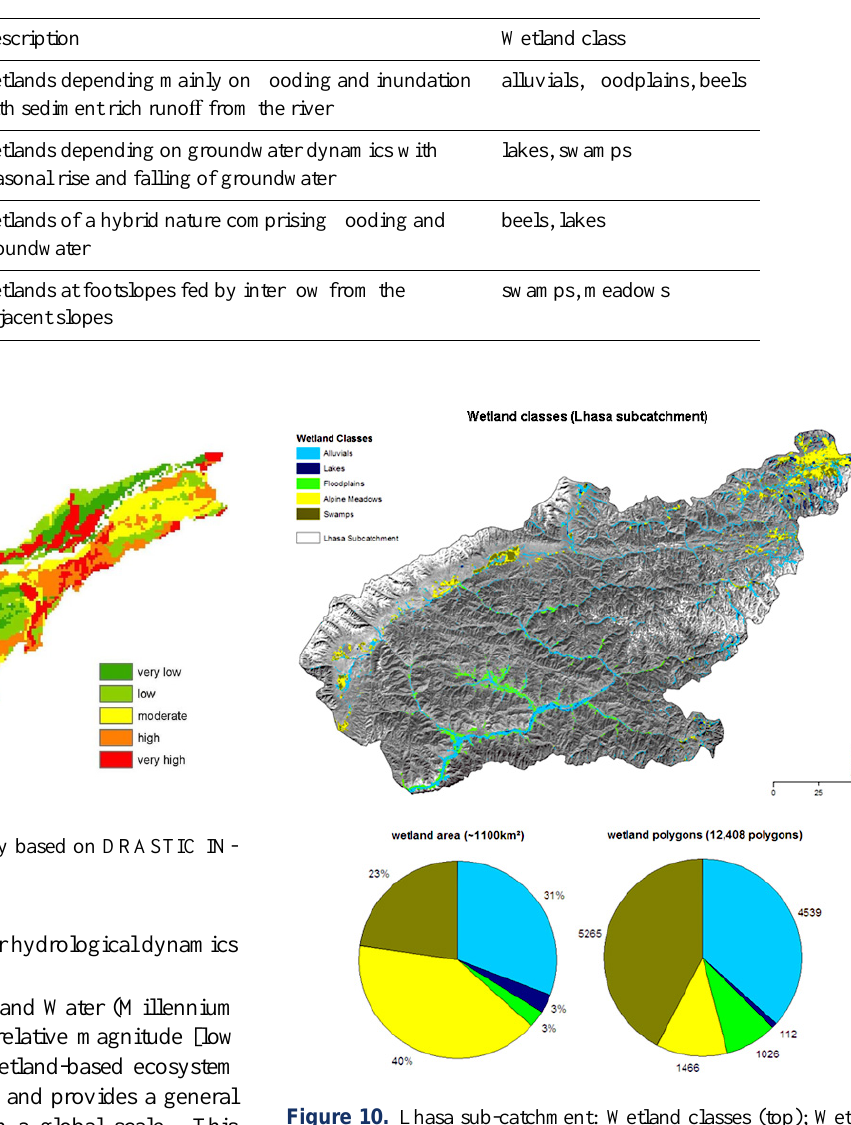
Table 7. Hydrological classes based on the hydrological dynamics of the di ff erent wetlands (Keddy, 2000).